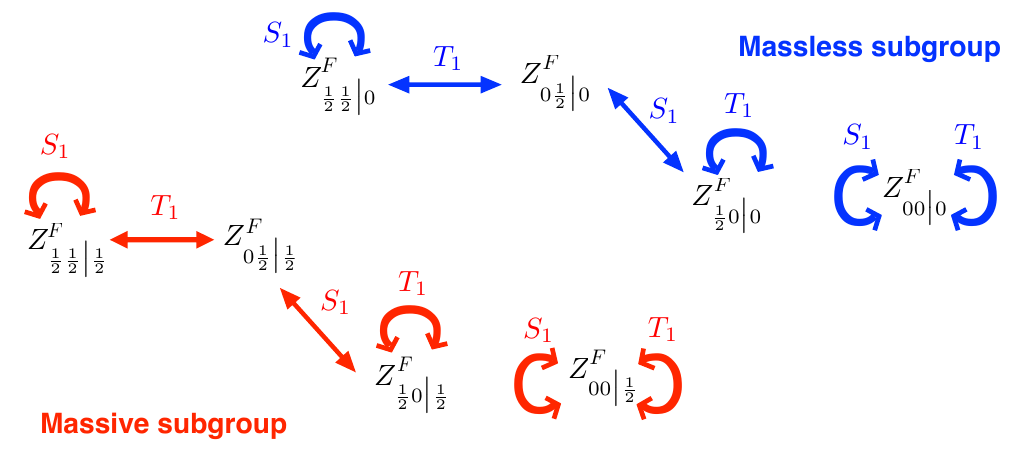
Figure 7 . Action of the modular group SL(2 ; Z ) over of the eight fermionic partition func- tions (2.67){(2.71) dimensionally reduced to the ( x 0 ; x 1 ) plane. Their transformations under the subgroup SL(2 ; Z ) are the same of those of the massless sector, and are indicated as the ‘massive subgroup’ in (cid:12)gure